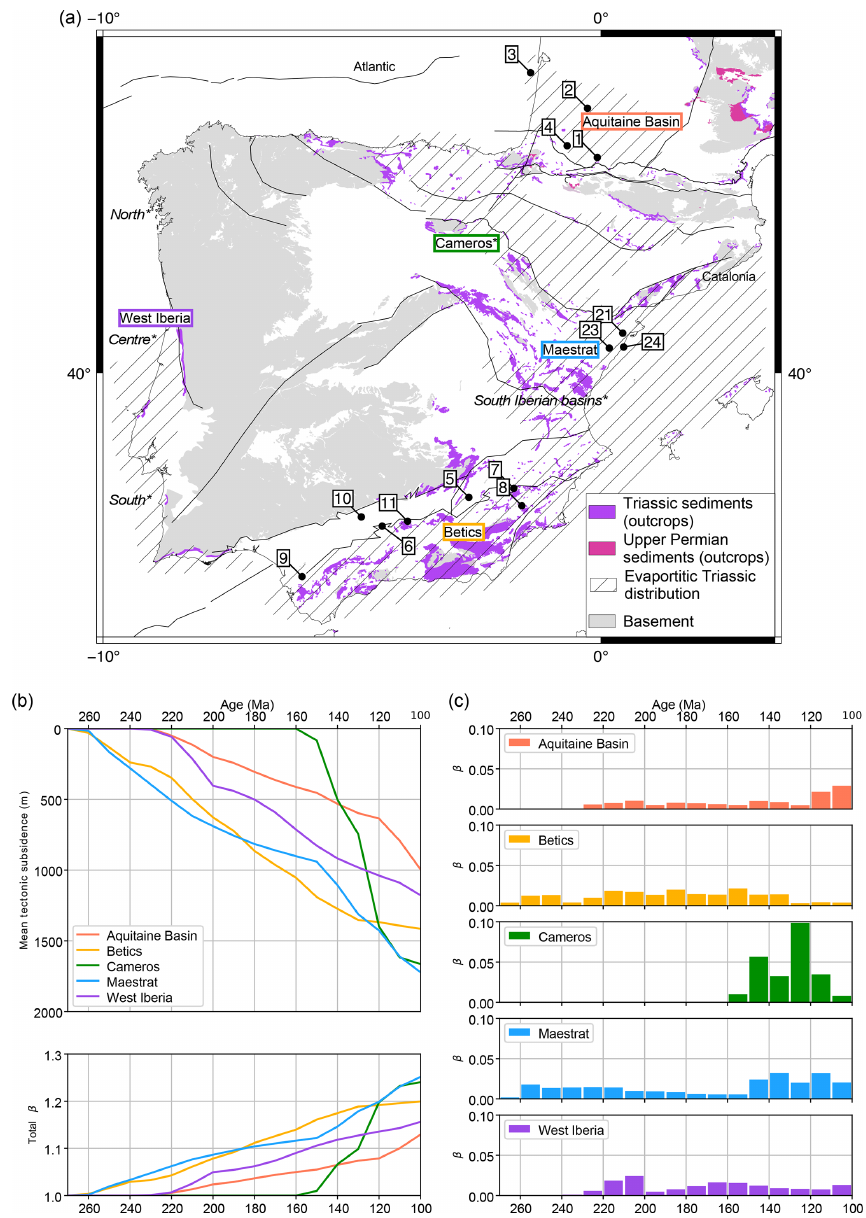
Figure 3. Late Permian–Triassic deposits and subsidence analyses. (a) Map of the upper-Permian–Triassic sediment outcrops, main depocen- ters, and distribution of the Upper Triassic evaporitic sequence in Iberia and southwest France. (b) Top: mean tectonic subsidence curves in the Aquitaine Basin (Brunet, 1984), Betics (Hanne et al., 2003), Cameros Basin (Salas and Casas, 1993; Salas et al., 2001; Omodeo-Sale et al., 2017), Maestrat Basin (Salas and Casas, 1993; Salas et al., 2001), and West Iberia (Spooner et al., 2018). See Supplement for indi- vidual tectonic subsidence curves in each region. (1) Ger1; (2) Lacquy1; (3) Sextant1; (4): Lacq301; (5) Santiago de la Espada; (6) Nueva Carteya1; (7) Rio Segura G1; (8) Espugna; (9) Betica 18-1; (10) Rio Guadalquivir; (11) Fusanta; (12) Lazaro; (13) Fuentatoba ∗ ; (14) Poveda ∗ ; (15) Cameros2 ∗ ; (16) Enciso ∗ ; (17) Rollamentia ∗ ; (18) Castellijo ∗ ; (19) Molino ∗ ; (20) Yanguas ∗ ; (21) Mirambell; (22) Amposta Marino C3; (23) Salzedella; (24): Maestrazgo; (25): South Iberian Basin; (26): West Iberia south; (27): West Iberia central; (28): West Iberia north. Synthetic wells (shown by ∗ ) are not represented on the map. Bottom: total stretching factor ( β ) (isostatic calculation, Watts, 2001) calculated from the mean tectonic subsidence of each region. (c) Incremental stretching factor ( β ) with a 10Myr time step.